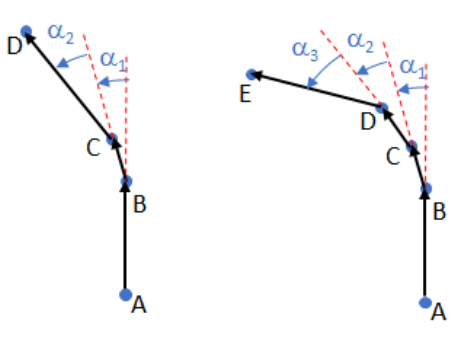
Figure 7. Composition of qualitative directions right , straight , slightly left , left } . We assigned such qualitat- ive directions to an equiangular conic domain. Assuming the angle of the straight direction to be 0 ◦ degrees and directions to be measured anticlockwise, the qualitative directions are as- signed to the intervals [ − 112 . 5 ◦ .. − 67 . 5 ◦ ] , [ − 67 . 5 ◦ .. − 22 . 5 ◦ ] , [ − 22 . 5 ◦ .. + 22 . 5 ◦ ] , [+22 . 5 ◦ .. + 67 . 5 ◦ ] , [+67 . 5 ◦ .. + 112 . 5 ◦ ]